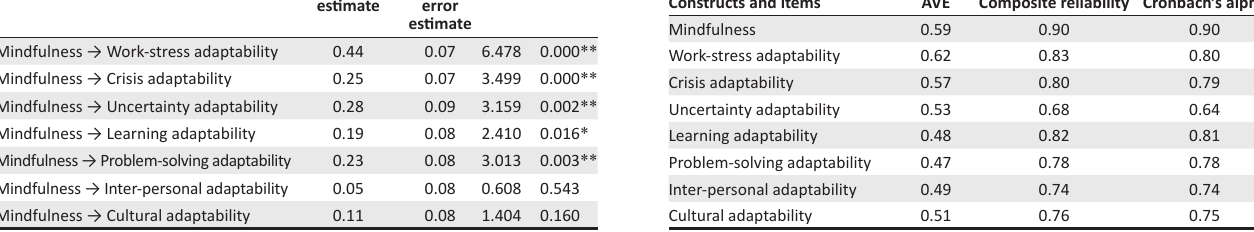
TABLE 1: Standardised estimates in the structural model. Path